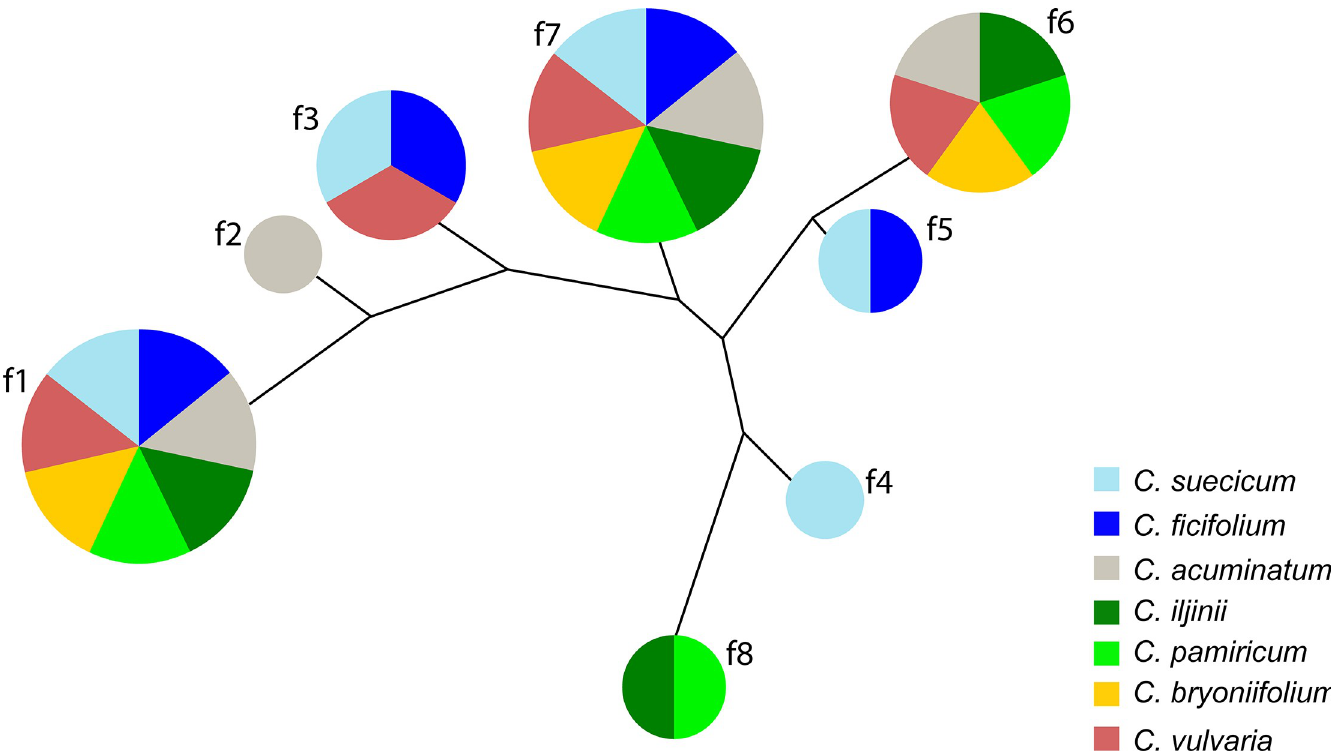
Fig 1. Relationships tree of the satDNA families identified in the genomes of diploid C . album aggregate species. The size of the circle is proportional to the number of species in whose genomes the satDNA family occurs.